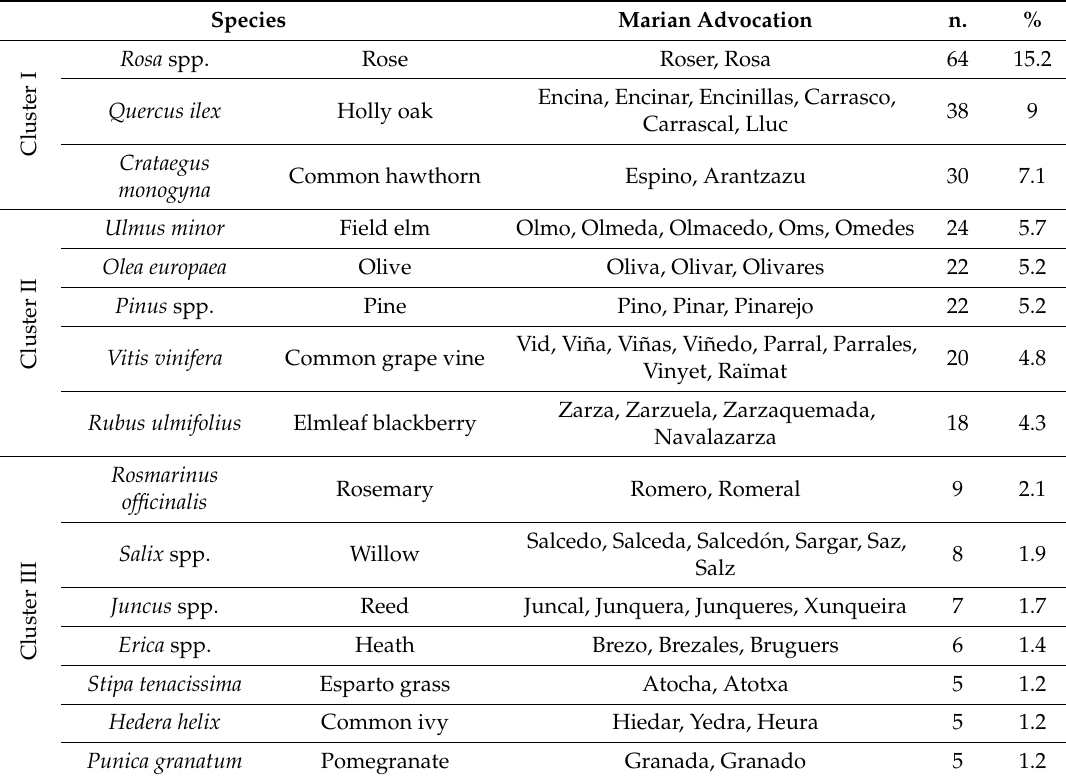
Table 4. Most common Marian verdant advocations ( ≥ 1%). Species Marian Advocation